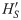
Schematic of vector-borne disease dynamics model when host immunity can be pre-sensitised through vector saliva pre-exposure.Susceptible hosts (HS) may become pre-sensitised (HS′) when bitten by either a susceptible vector (VS), an exposed but non-infectious vector (VE), or an infectious vector (VI) if parasite transmission is unsuccessful. Susceptible hosts that are pre-exposed to vector saliva remain sensitised until the protective status is lost over time. Susceptible pre-sensitised and naïve hosts (HS′ and HS respectively) can become infected (HI′ and HI respectively) when bitten by an infectious vector. Upon recovering from infection, the host gains immunity against future infections (HR), but that immunity wanes over time. Further details can be found in Methods. Infection routes of hosts are shown in thick black; pre-sensitisation routes in grey; infection of vectors in thin black. The movement between classes is shown in solid lines and the interactions that lead to that movement are shown by dashed lines.